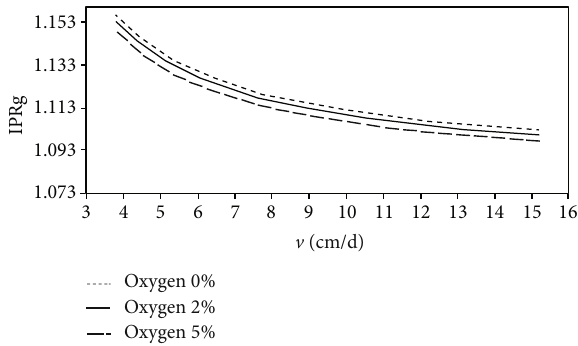
Figure 4: The e ff ect of oxygen utilization on gas injection- production ratio.